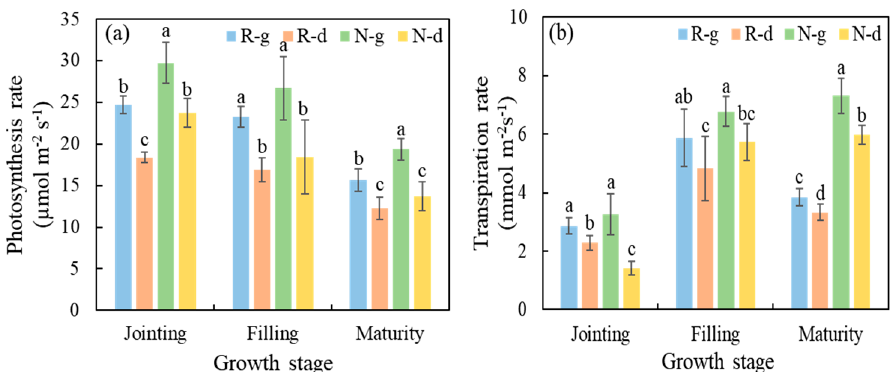
Figure 3. Effects of warming and drought stress on photosynthetic and transpiration rates of winter wheat. Each data point indicates the average value of three replicates. The lowercase letters indicate significant differences ( p < 0.05). ( a ) Photosynthetic rate at different growth stages; ( b ) Transpiration rate at different growth stages.